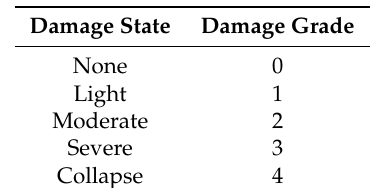
Table 1. Characterizing the damage.